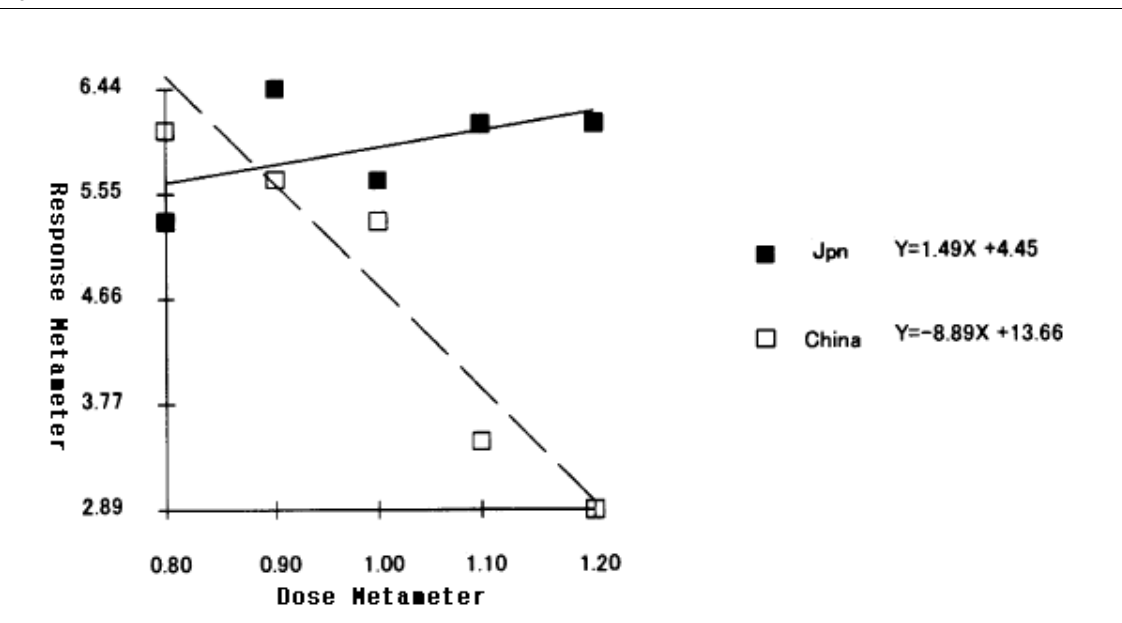
) of Agkistrodon halys (Jpn) and 50